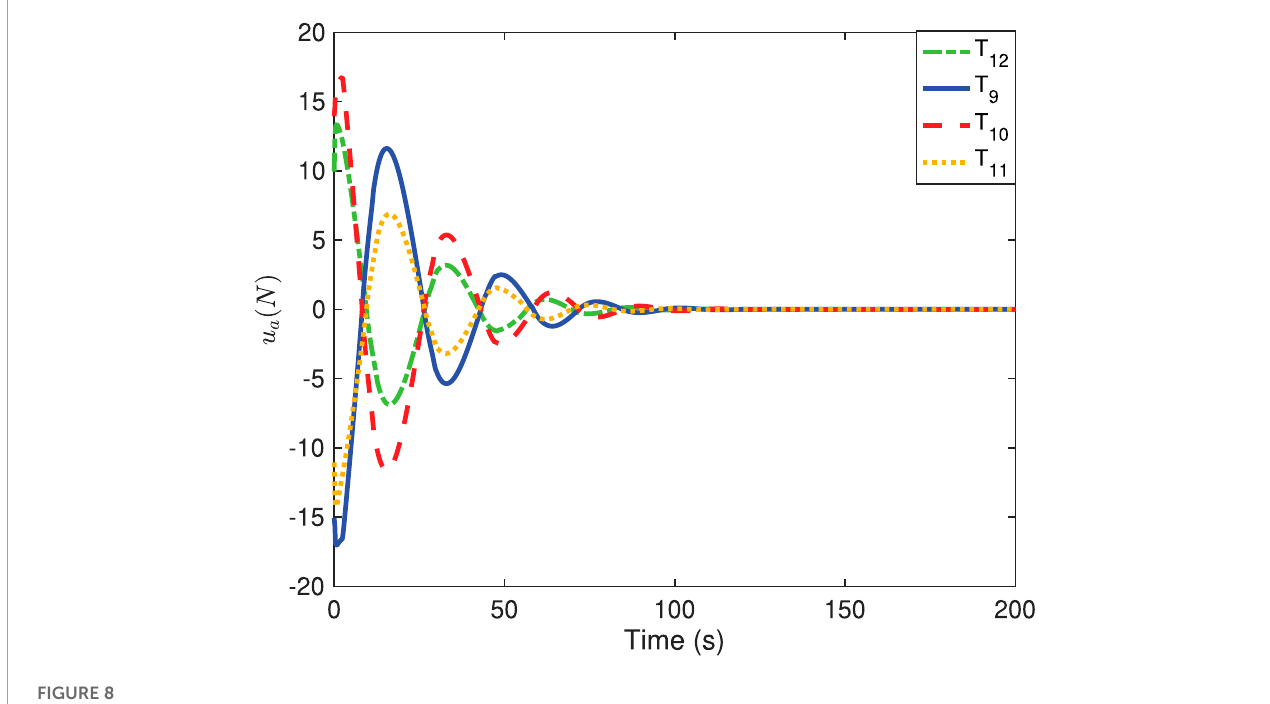
FIGURE 8 Thruster forces of #9-#12 in the STC.